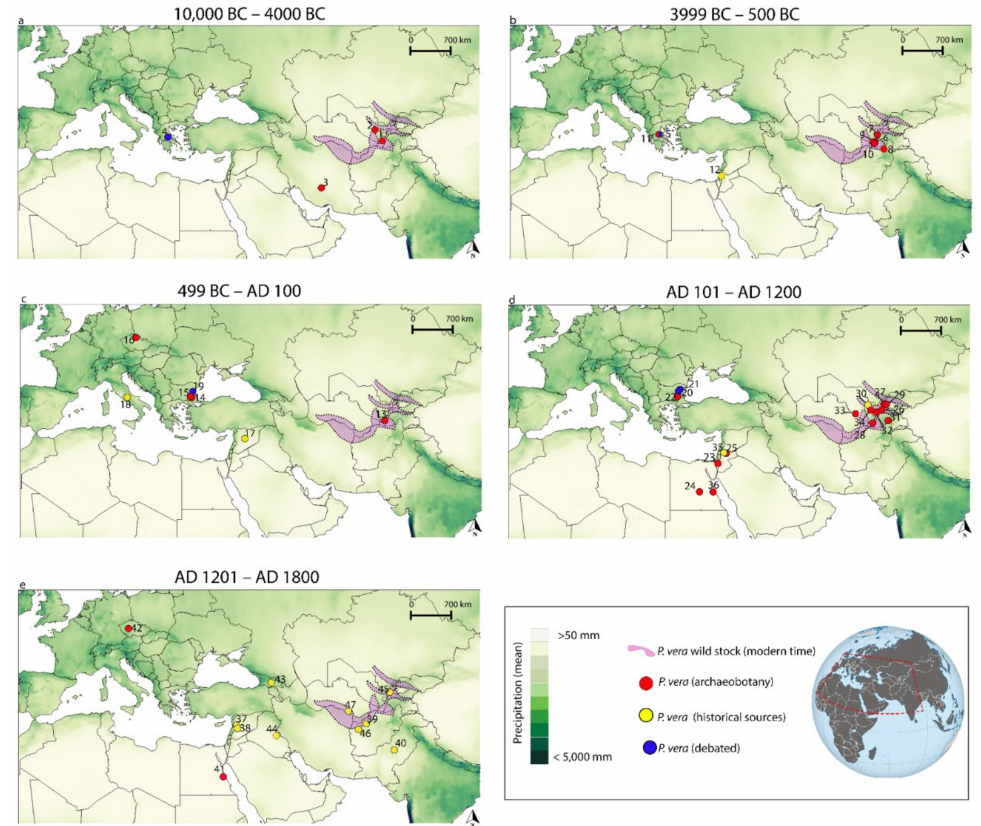
Figure 2. Modern geographical distribution of P. vera wild stock were estimated based on